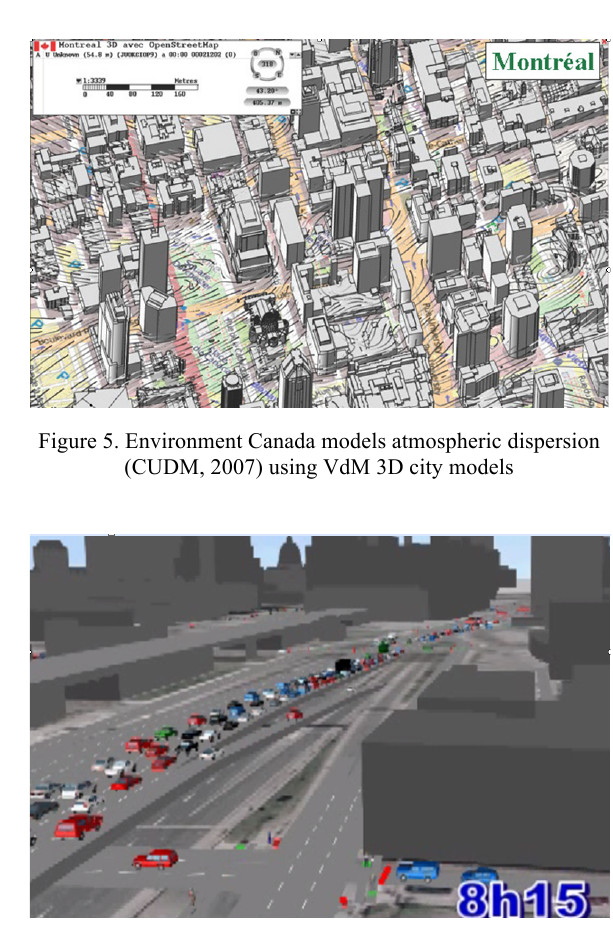
Figure 6. VdM’s Transportation Department is modeling 3D road traffic using the VISSIM software from DYNAMEQ database (Volet et al., 2008)